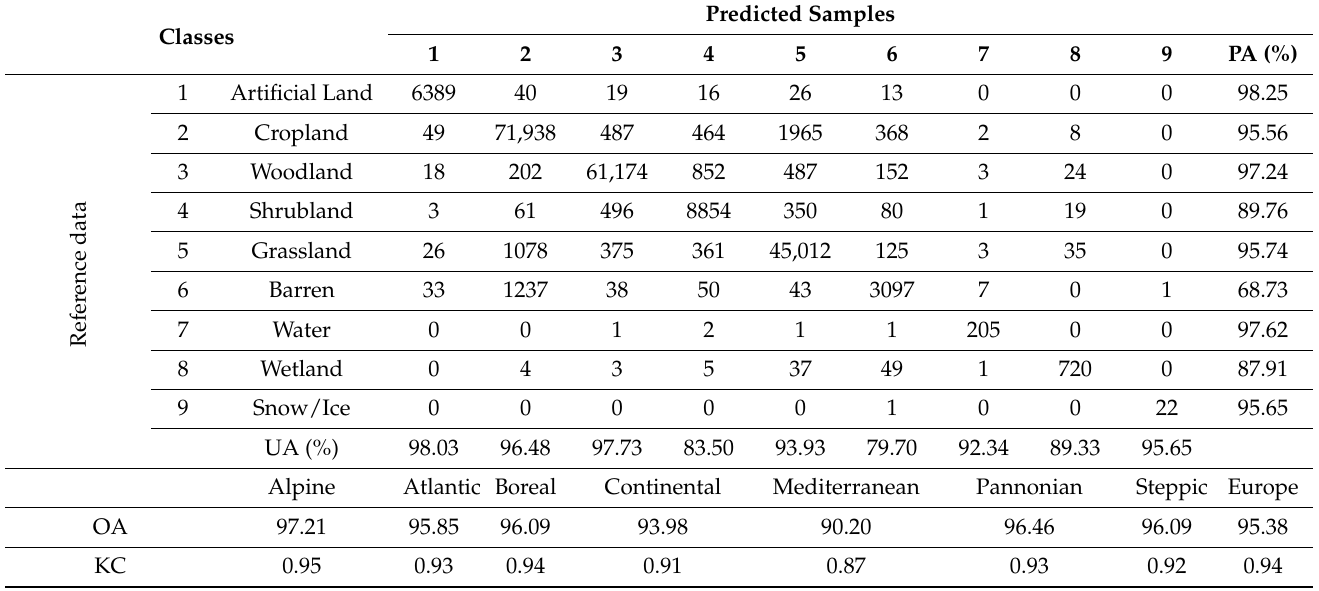
Table 4. The confusion matrix of the post-processed ELULC 10 map, along with OAs and KCs of all classes in seven biogeographical